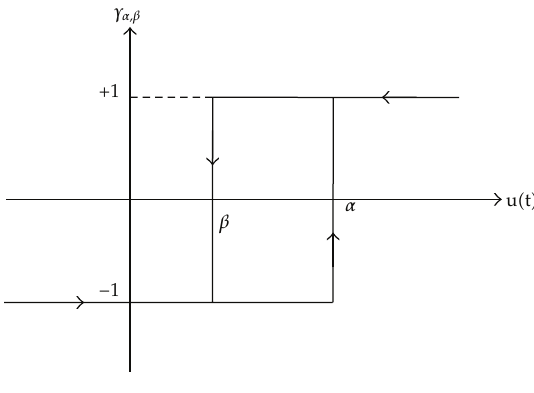
Figure 1: Preisach elemental operator.